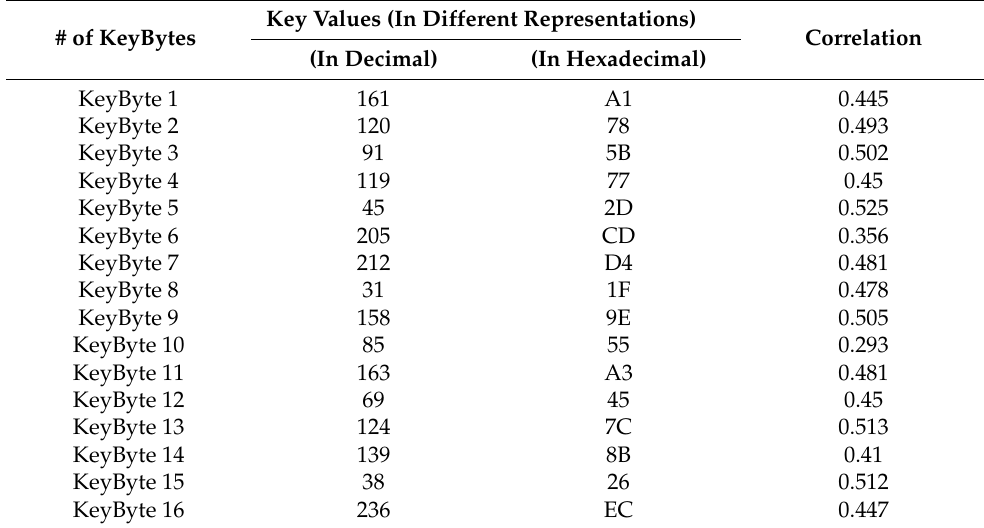
Table 2. The achieved correlated values for 16 bytes of AES-128